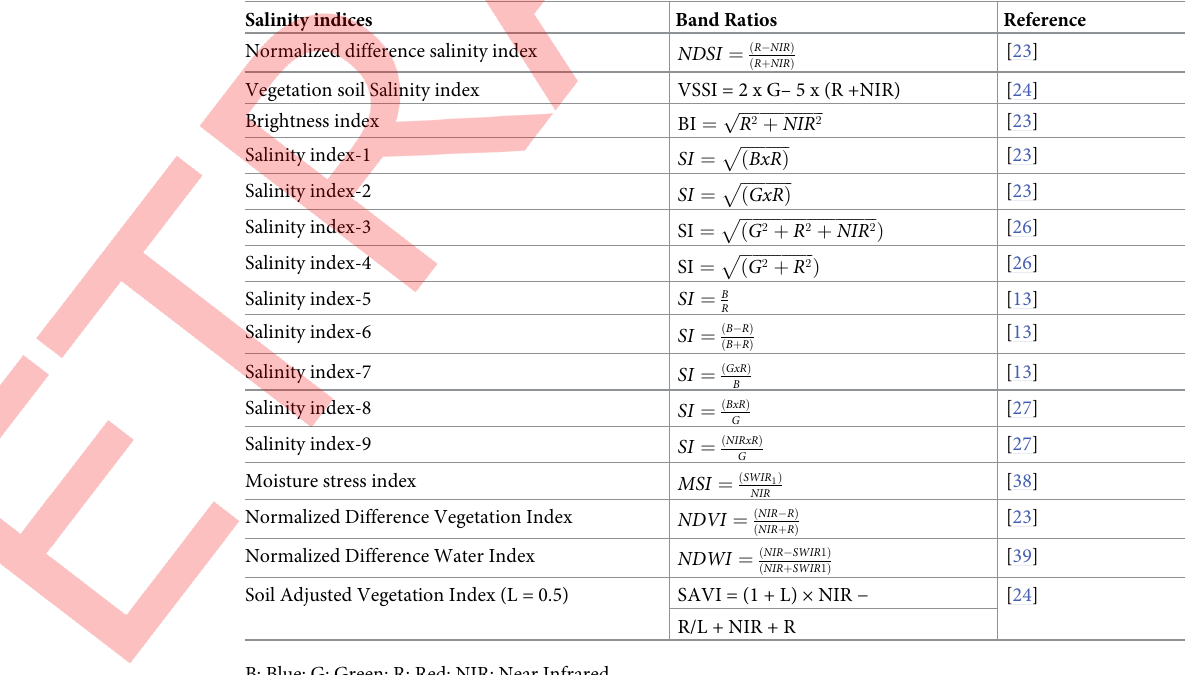
Table 3. Equations used to analyze spectral soil salinity and vegetation